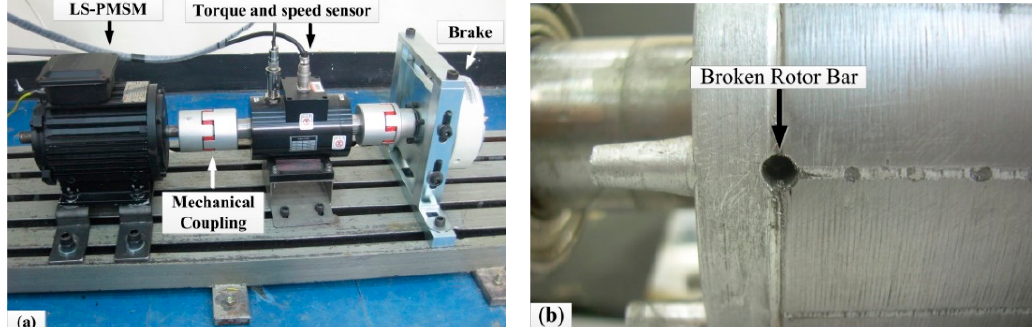
Figure 8. ( a ) The experimental test rig and ( b ) the rotor with one broken rotor bar (BRB).